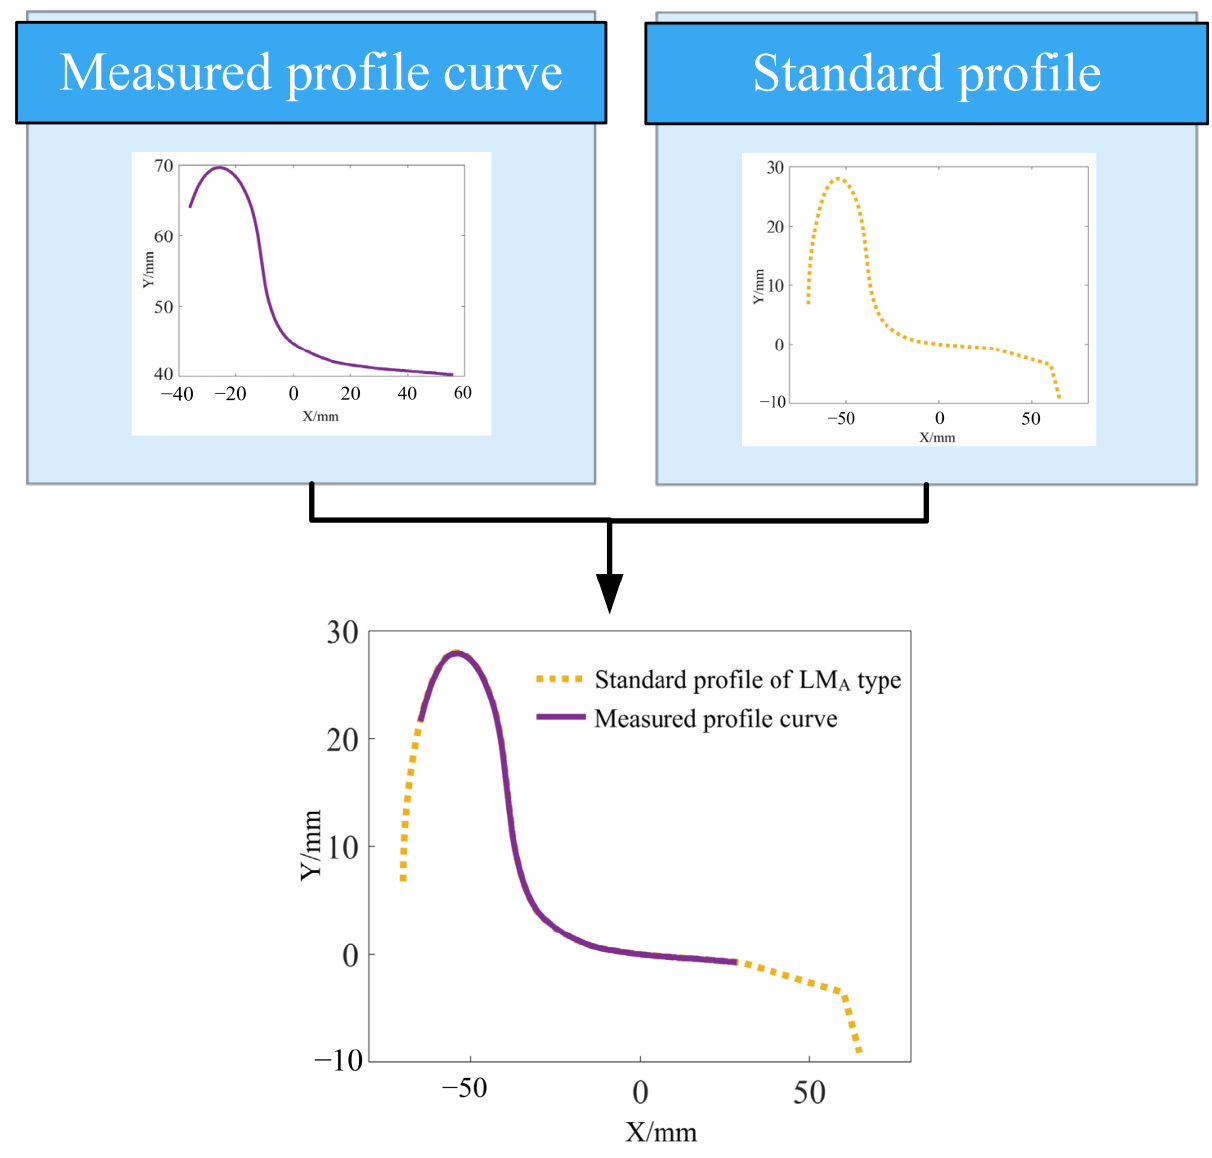
Figure 9. Registration of measured curve to standard profile